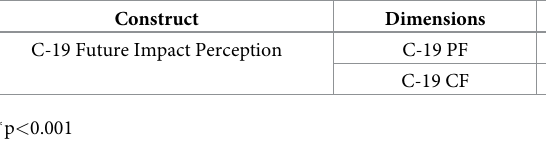
Table 7. Validity results for formative second-order construct.